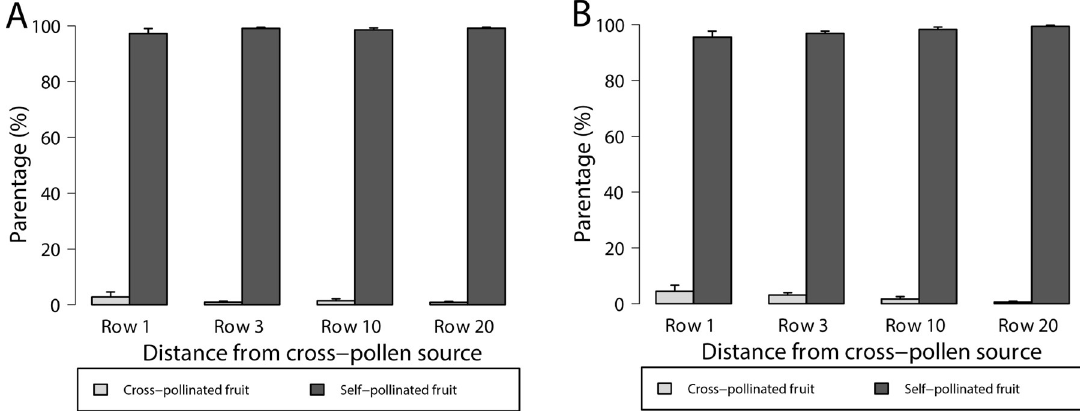
Fig 3. Percentage of partly cross-pollinated and fully self-pollinated fruit of (A) Red Rhapsody and (B) Sundrench strawberry at different numbers of rows from a cross-pollen source. Fruit were sampled along transects starting at plants adjacent to another cultivar (Row 1) and ending in the middle of a single-cultivar block (Row 20). Means (+SE) for cross-pollination levels for each cultivar are not significantly different across rows (GLM, p > 0.05, n = 6).